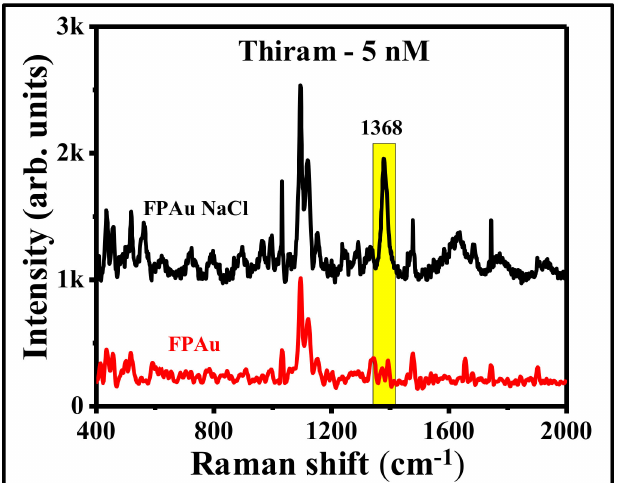
Figure 10. SERS spectra of thiram-5 nM molecule using FP-loaded with ps laser ablated of Au NPs in the presence of distilled water (FPAu-red color) and NaCl-20 mM (FPAu